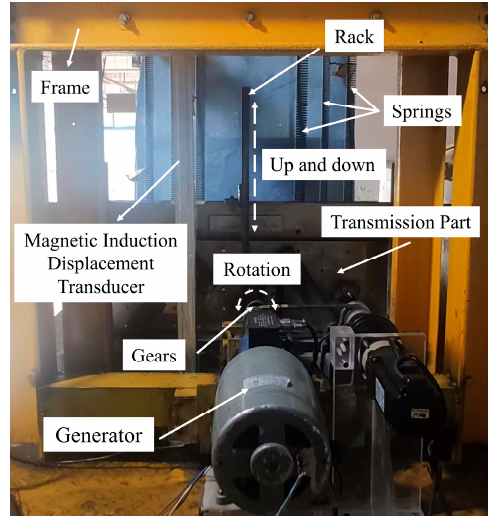
Figure 5. Transmission part-generator.